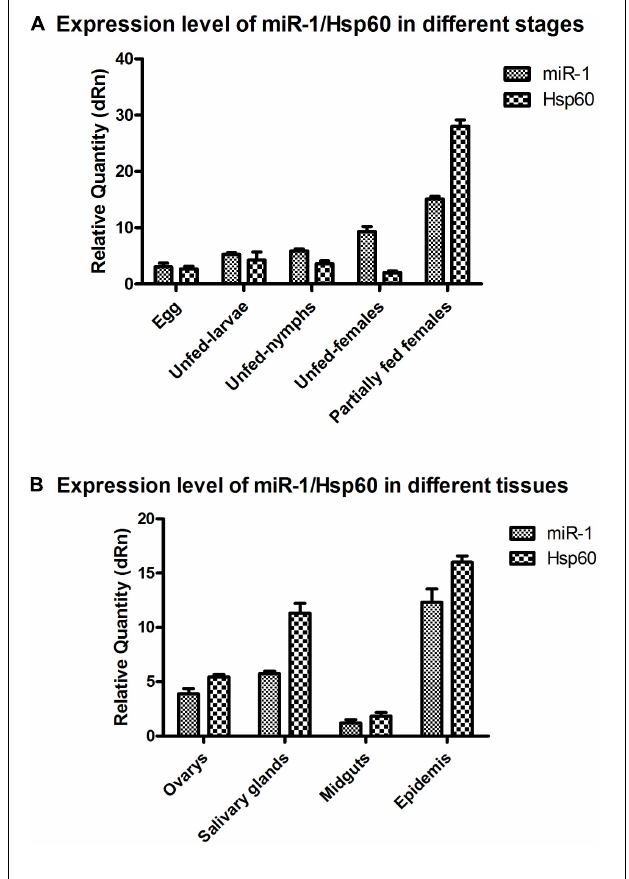
FIGURE 8 | miR-1 and Hsp60 expression in different developmental stages and tissues. (A) Relative expression of Hsp60 and miR-1 was analyzed in eggs, unfed larvae, unfed nymphs, unfed adult females, and partially fed adult females. (B) Relative expression of Hsp60 and miR-1 in the ovary, salivary glands, midgut, and epidermis of fed adult female ticks. Data represent three biological replicates with three technical replicates and are shown as the mean ± SEM.